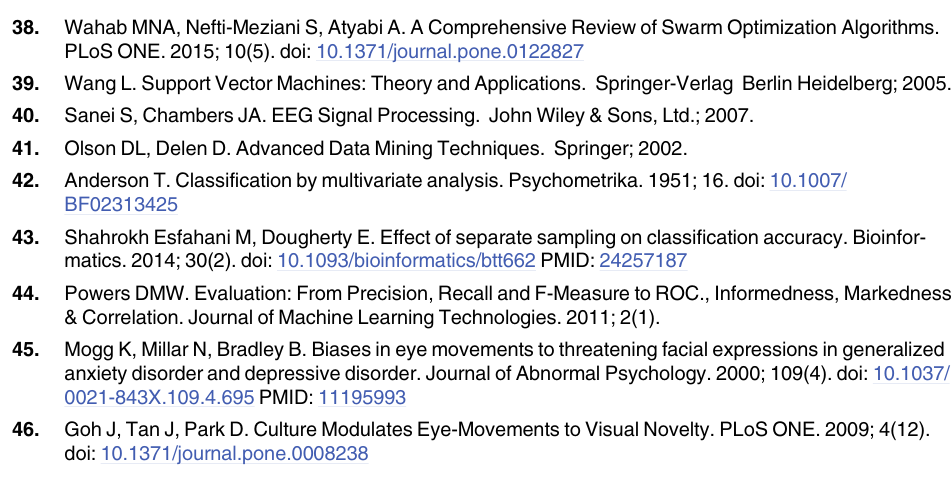
PLOS ONE | DOI:10.1371/journal.pone.0138198 September 25,